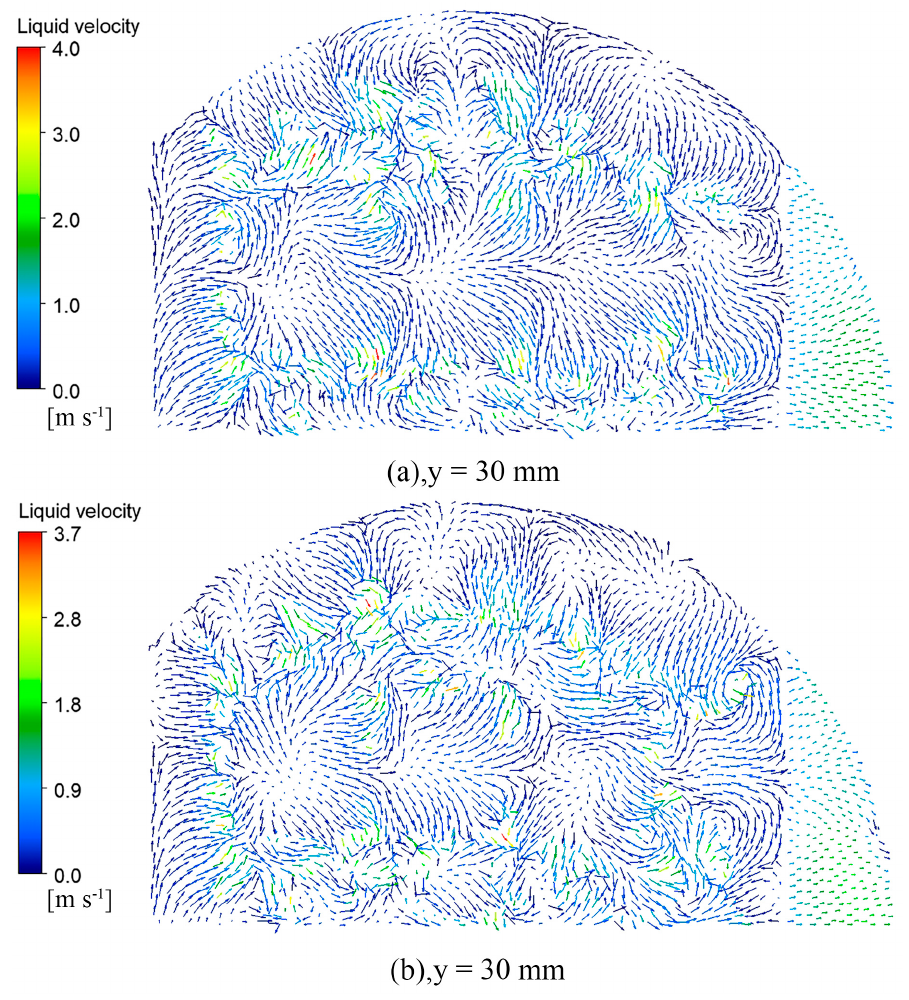
Figure 17. Liquid velocity vector snapshots of the top view at y = 30 mm: ( a ) rectangular guided valve tray; ( b ) parabolic–shaped guided valve tray.